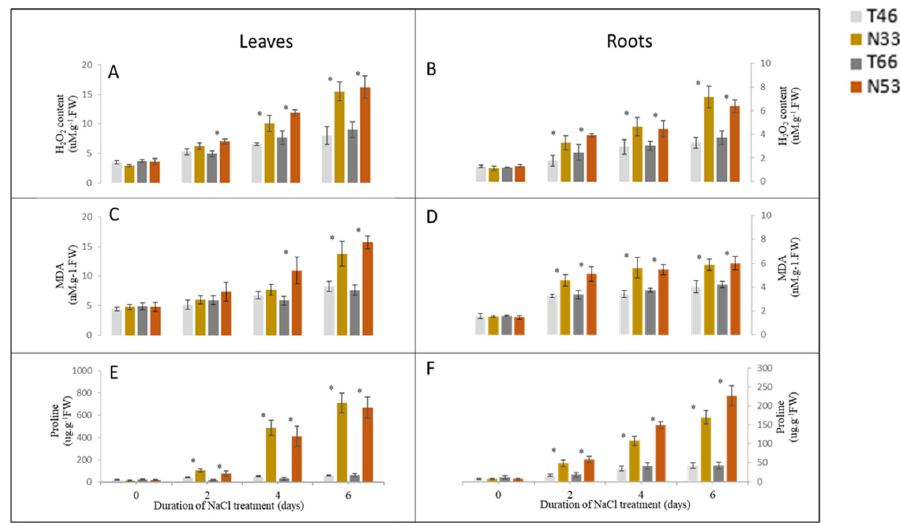
Figure 4. Comparison of , H 2 O 2, MDA and proline contents in leaves ( A , C , E ) and roots ( B , D , F ) of two pairs of NILs at 0, 2, 4, and 6 days after 300 mM NaCl treatment. * indicates significant differences among NILs ( p < 0.05, Student’s t -test).